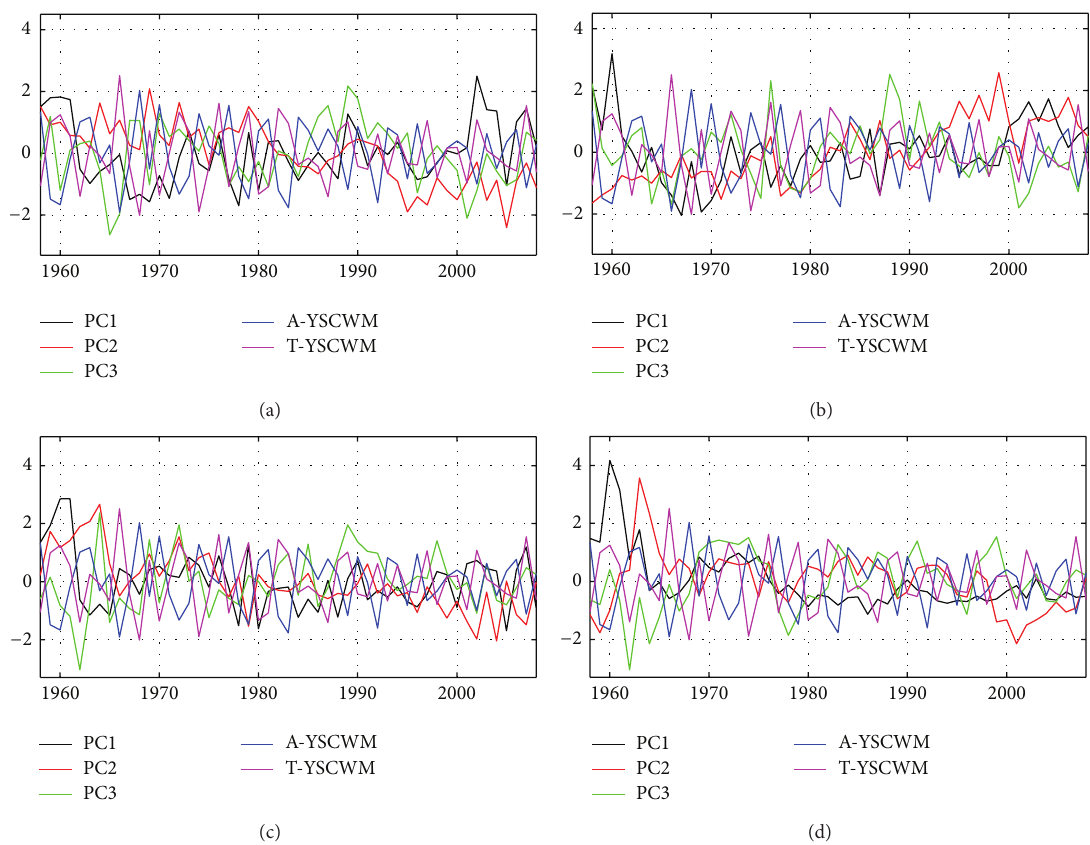
Figure 6: Interannual time series of (a) EOF1, EOF2, and EOF3 of winter heat flux, and the A-YSCWM and T-YSCWM in August (b) EOF1, EOF2, and EOF3 of summer heat flux, and the A-YSCWM and T-YSCWM in August (c) EOF1, EOF2, and EOF3 of winter wind stress, and the A-YSCWM and T-YSCWM in August (d) EOF1, EOF2, and EOF3 of summer wind stress, and the A-YSCWM and T-YSCWM in August. All-time series are standardized. The A-YSCWM and T-YSCWM represent the area and averaged temperature of the YSCWM, respectively.